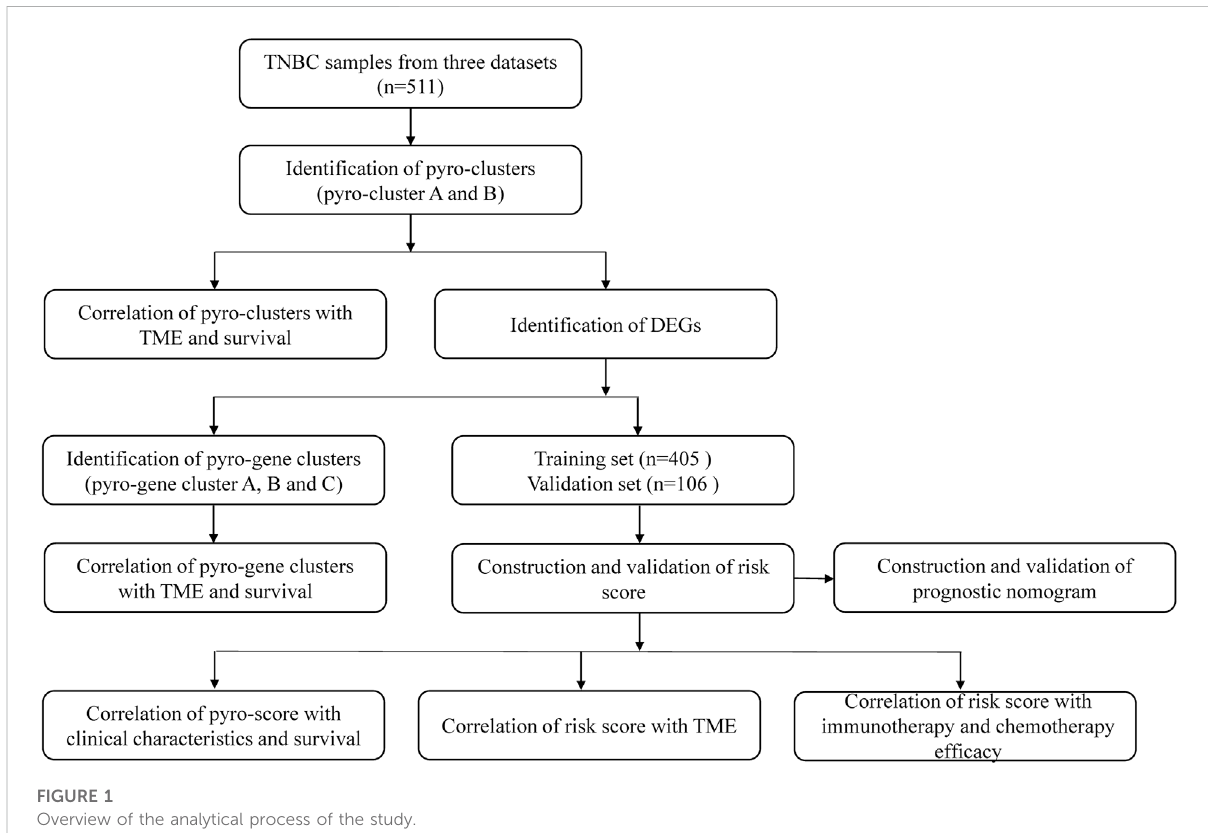
FIGURE 1 Overview of the analytical process of the